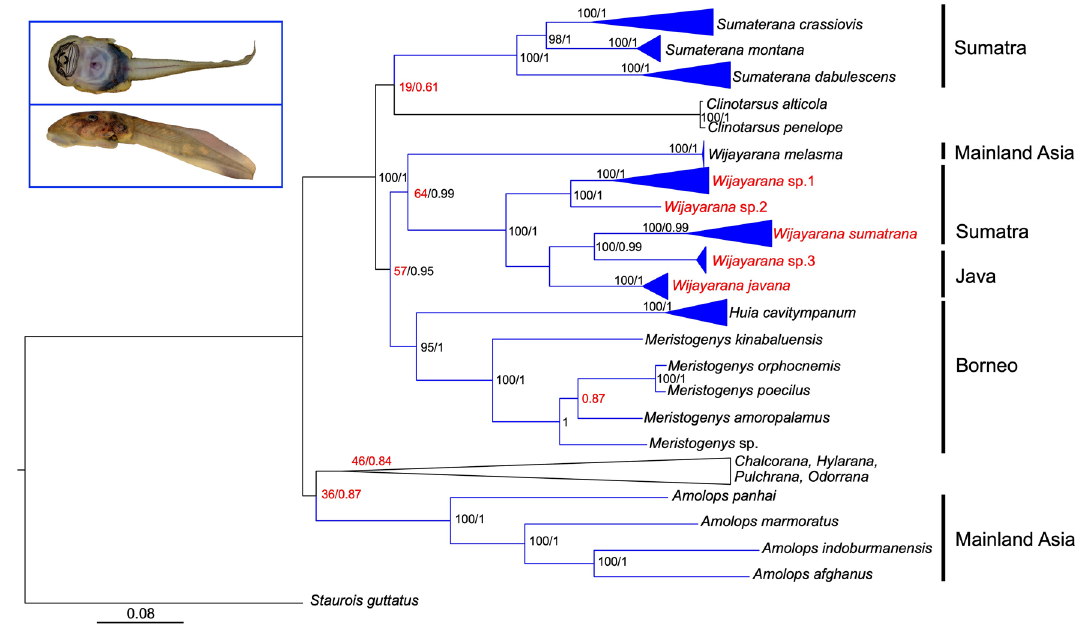
Figure 1. BI tree showing phylogenetic relationships of the Sumatran ranids with gastromyzophorous tadpoles (blue branches) within the family Ranidae. Values denote bootstrap and posterior probabilities (BS/PP). For node between Meristogenys amoropalamus and M. orphocnemis + M. poecilus and the node between this clade and Meristogenys sp, only PP value. Red taxa represent the five distinct lineages of Wijayarana from Sumatra and Java. Morphology of gastromyzophorous tadpoles (ventral and lateral view; photos by UA) is shown on the upper